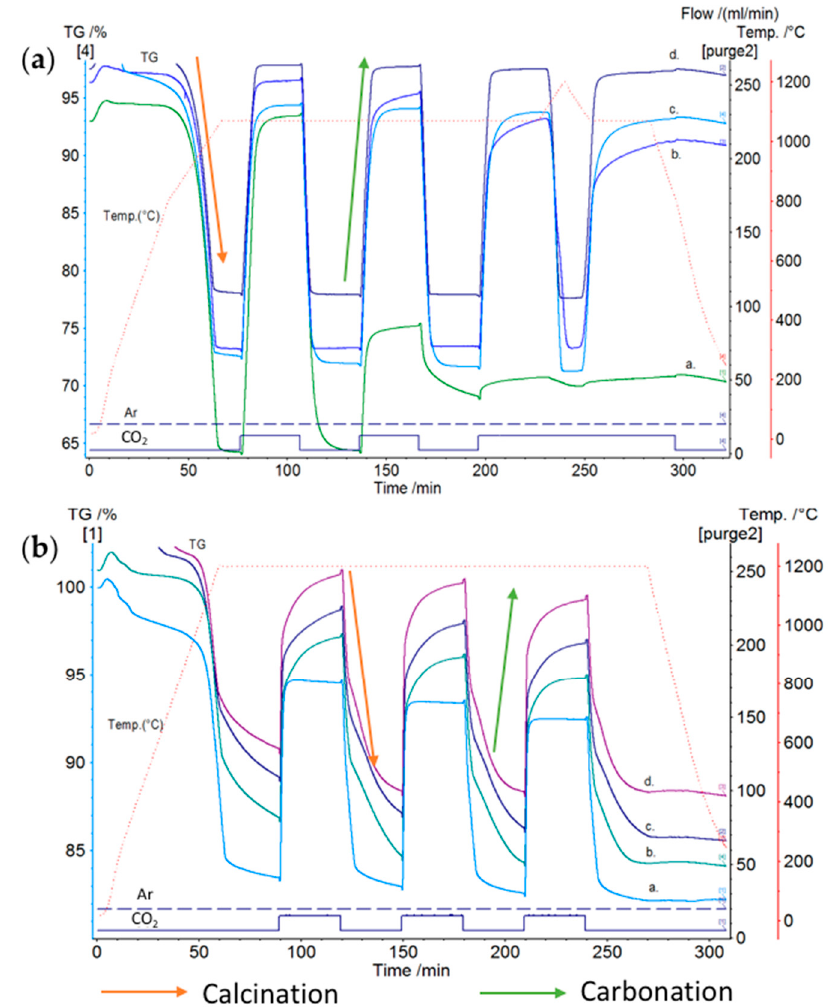
Figure 4. Thermogravimetry (TG) analysis of SrCO 3 / SrO and BaCO 3 / BaO showing cycling stability improvement of carbonates via the addition of MgO as inert additive [33]. ( a ) SrCO 3 / SrO (a. commercial SrCO 3 , b. commercial SrCO 3 with 20 wt% MgO, c. SrCO 3 synthesized with 20 wt% MgO, d. commercial SrCO 3 with 32 wt% MgO), and ( b ) BaCO 3 / BaO (a. commercial BaCO 3 with 44 wt% MgO, b. synthesized BaCO 3 with 30 wt% MgO, c. 30 wt% MgO presenting low porosity, d. 30 wt% MgO presenting high porosity).